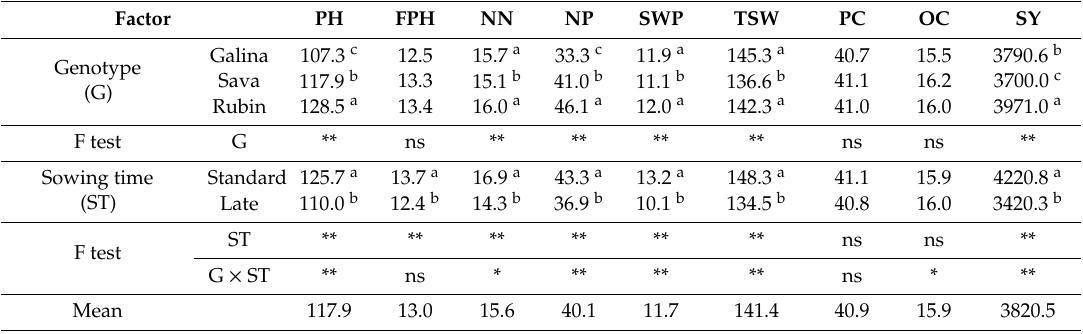
Table 3. Genotype and sowing time e ff ects on the quantitative and quality traits in 2018. Factor PH FPH NN NP Genotype (G)